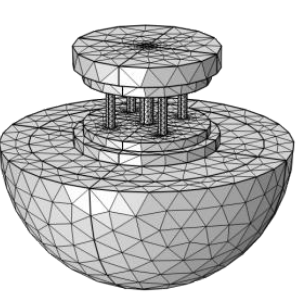
Figure 9. Schematic diagram of transducer modeling.